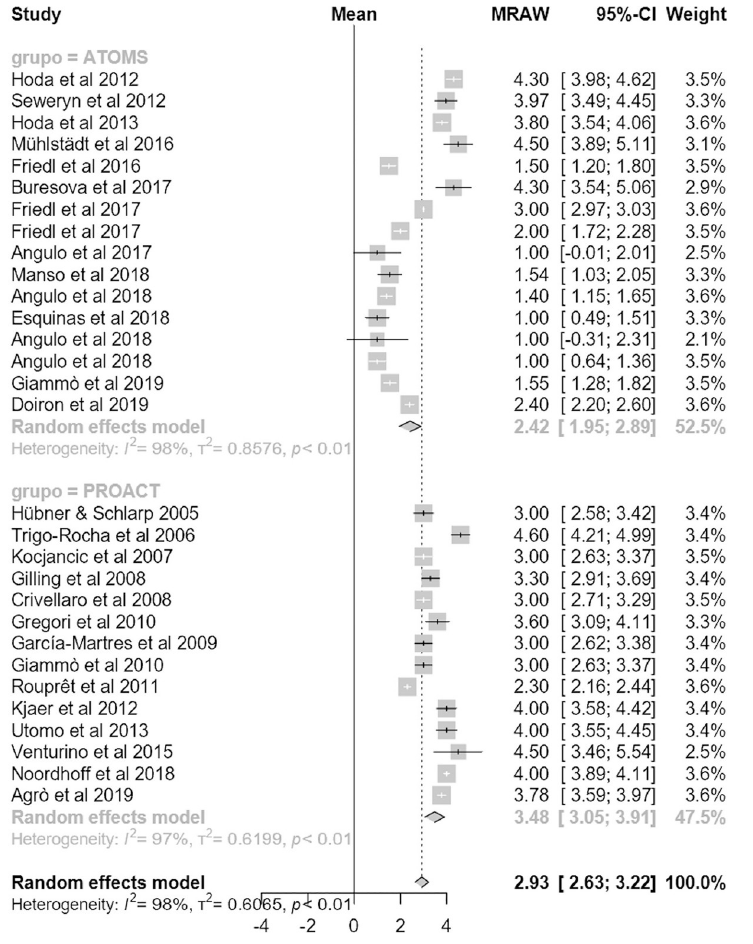
Fig 5. Forest plot of studies analyzed with number of